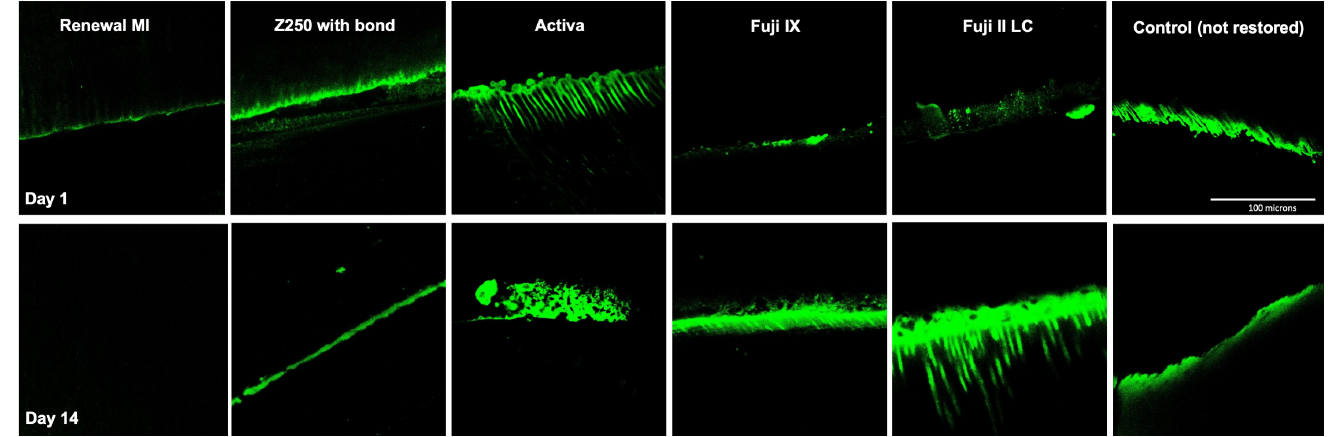
Figure 6. Representative CLSM images (204 × 204 µm) demonstrating MMP activity (in green) after 1 day and 14 days at the adhesion interface between Renewal MI, Z250 with bonding agent, Activa, Fuji IX or Fuji II LC and demineralized dentine. Non-restored demineralized dentine was used as a negative control.